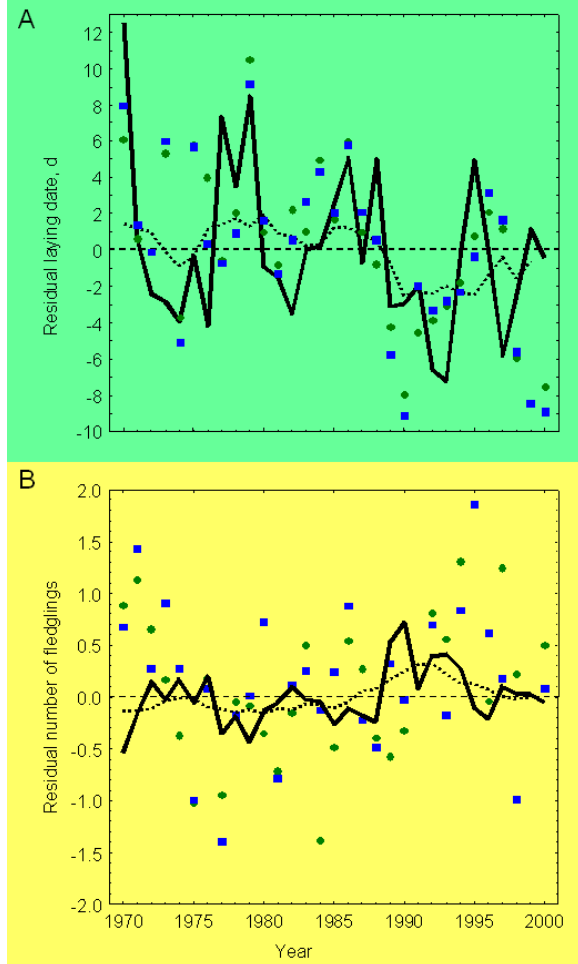
Figure 3. Validation of structural equation model results against independent observational data. (a) Breeding phenology and (b) reproductive output in Braunschweig (Germany) 1970 – 2000, given as the residual from the overall average for the great tit (circles, 31 years) and the blue tit (squares). Solid lines give predicted values as calculated from NAOI/NCPI data according to equations in fig. 1. Dotted lines give 11-year moving averages of predicted values (declining to 3-years at end points).